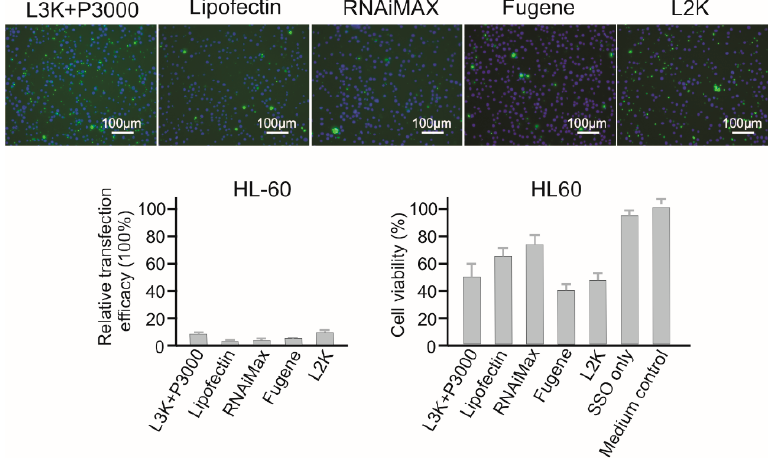
Figure 7. In vitro transfection efficiency and cytotoxicity of different transfection reagents in HL60 cells. L3K: Lipofectamine 3000, L2K: Lipofectamine 2000.